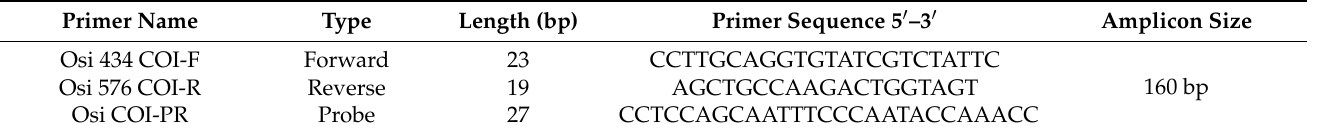
Table 1. Species-specific primers and probe designed to amplify a 160 bp fragment of the COI region of O. siamensis .